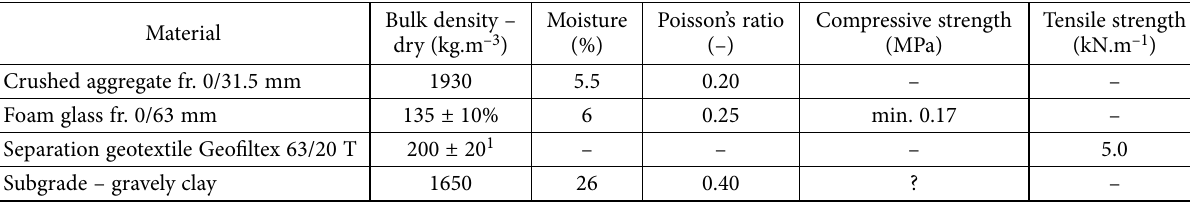
Table 1. Physical and strength parameters of the applied materials